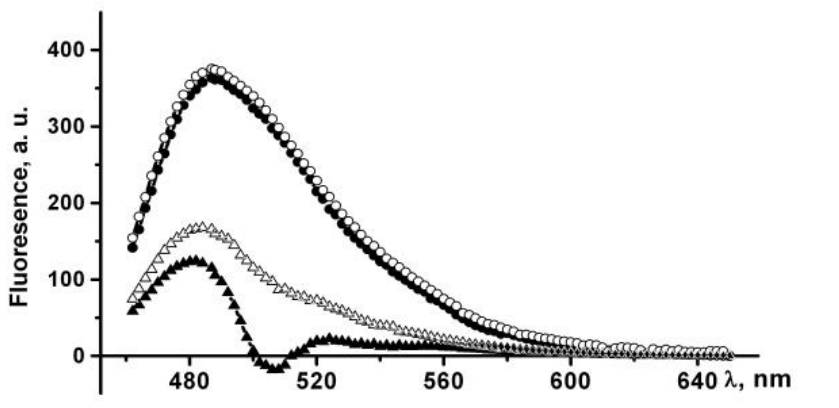
Figure 9. Difference fluorescence spectra of Thioflavin T bound to PldA-GFP IBs. IBs were incubated in PBS (triangle) and 0.04% SDS (circle) for 2 h (solid symbols) and 24 h (empty symbols). IBs treated with 0.04% SDS also bind ThT, which is accompanied by a 300-fold increase in the dye fluorescence intensity (Figure 9). The incubation time of IBs in a detergent solution (10 min and 24 h) does not affect the fluorescence intensity of a bound ThT.